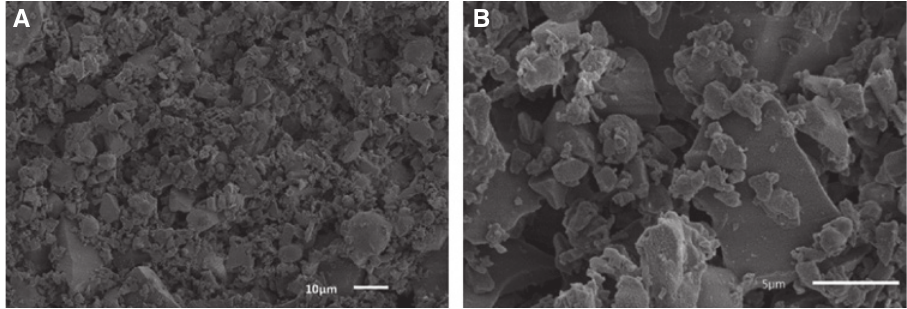
Figure 10: Surface morphology of C600 taken at different magnifications (A) × 1000 and (B) × 5000.